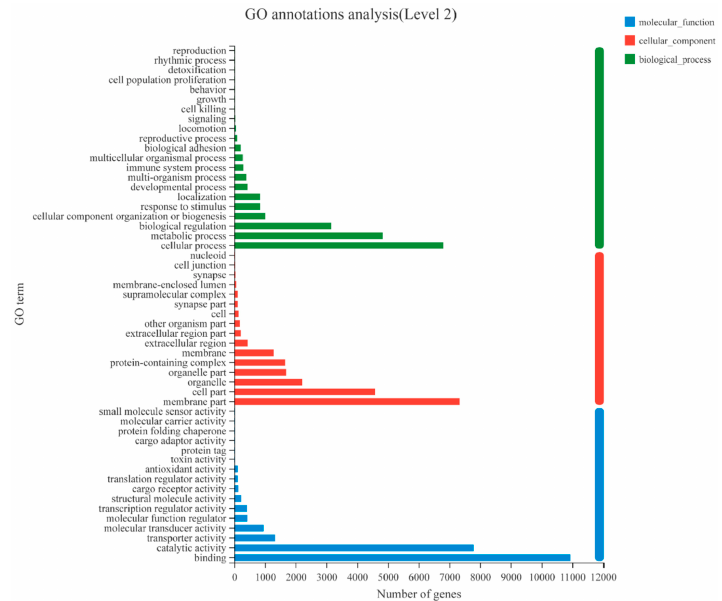
Figure 1. Gene ontology (GO) term distribution of transcripts. The GO annotation results were based on 20,199 transcripts detected at least in one of the five developmental stages. Gene ontology categories included molecular function, cellular component, and biological process. GO categories for each function were sorted by the increasing number of genes enriched in the process.